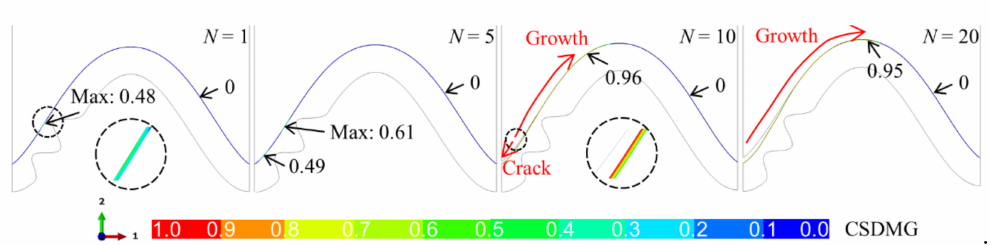
Figure 13. Evolution of the CSDMG in the ceramic layer near the interface including two bulges (at room temperature).